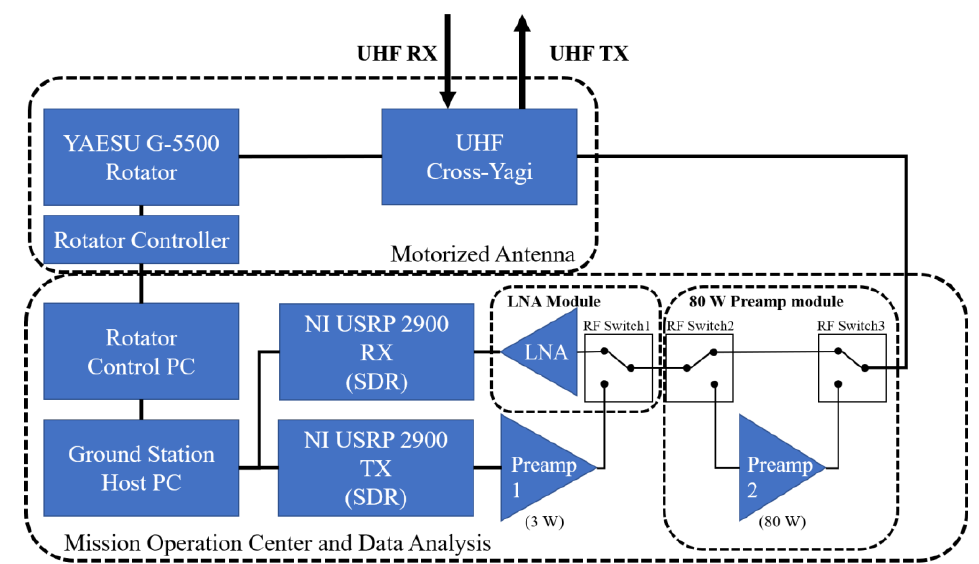
Figure 8. The basic architecture of the NCU UHF ground station.